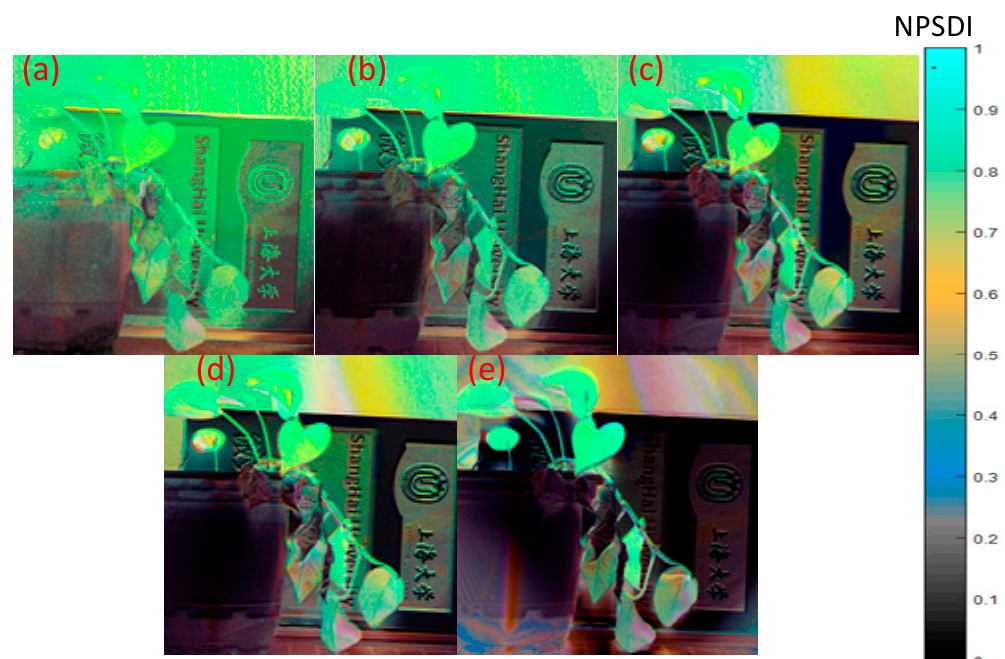
Figure 9. The fusion image (NDAI) with different illuminations. Illumination of the NDAI: ( a ) 0.01 lux, ( b ) 0.1 lux, ( c ) 0.5 lux, ( d ) 1.0 lux and ( e ) 5.0 lux.